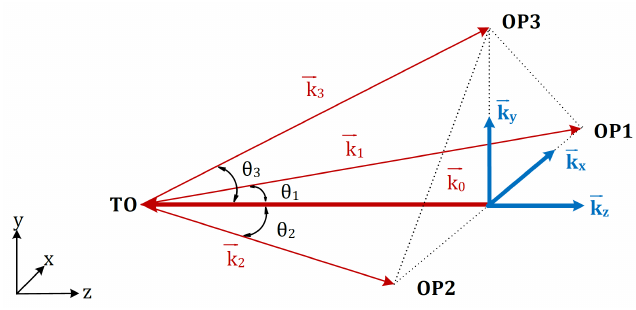
Figure 3. Evaluation of the sensitivity vectors (TO: test object; OP: observation